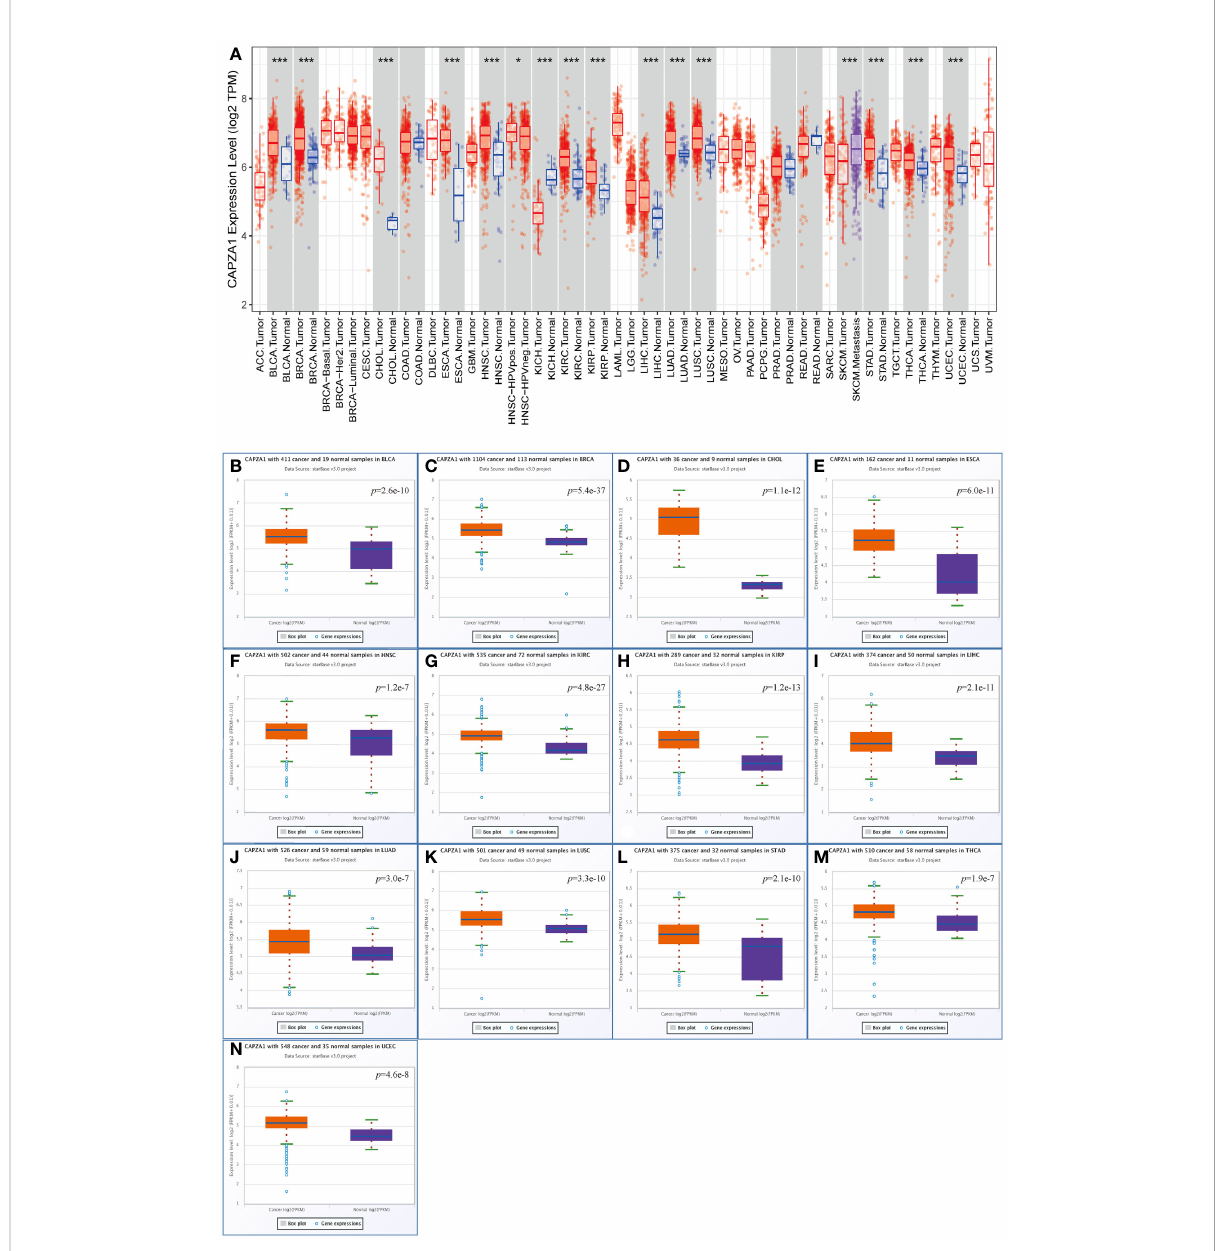
FIGURE 1 Expression analysis for CAPZA1 in multiple cancers. (A) The expression of CAPZA1 in 33 types of human cancer based on the TCGA cancer and normal data in TIMER. (B – N) CAPZA1 expression in the starBase BLCA. (B) , BRCA (C) , CHOL (D) , ESCA (E) , HNSC (F) , KIRC (G) , KIRP (H) , LIHC (I) , LUAD (J) , LUSC (K) , STAD (L) , THCA (M) , and UCEC (N) tissues compared with corresponding TCGA normal tissues. *p-value < 0.05; ***p-value <